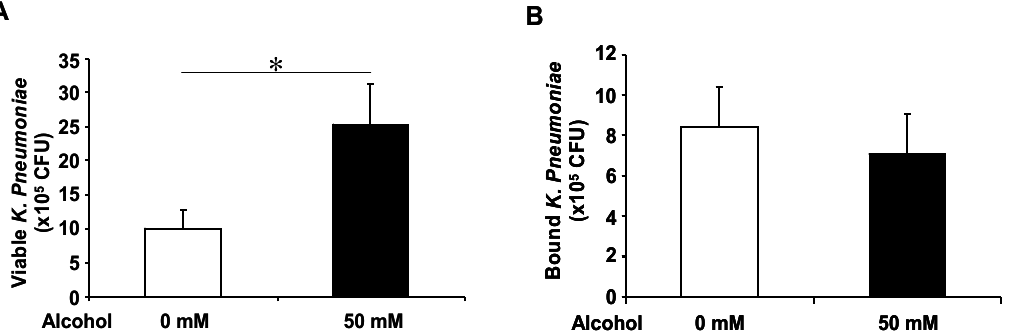
Figure 4. Alcohol effect on apical bacterial viability and binding. ( A ) Polarized NHBEs were treated with 0 and 50 mM of basolateral alcohol for 24 h and apically challenged with K. pneumoniae (MOI = ~10). The epithelia were lysed and bacterial supernatants were diluted and plated on agar plates for 24 h. The colonies were counted to estimate the viable colonies. Alcohol presence promoted the number of colonies on airway epithelia; ( B ) NHBEs were exposed to 0 and 50 mM of basolateral alcohol for 24 h and then apically applied with 14 C-labelled K. pneumoniae for 1 h. The cells were washed and lysed to count radioactivity. Bound bacterial numbers were determined by comparing the cell-retaining radioactivity with a pre-established standard curve with various bacterial numbers. As demonstrated, alcohol did not alter the number of K. pneumoniae bound to